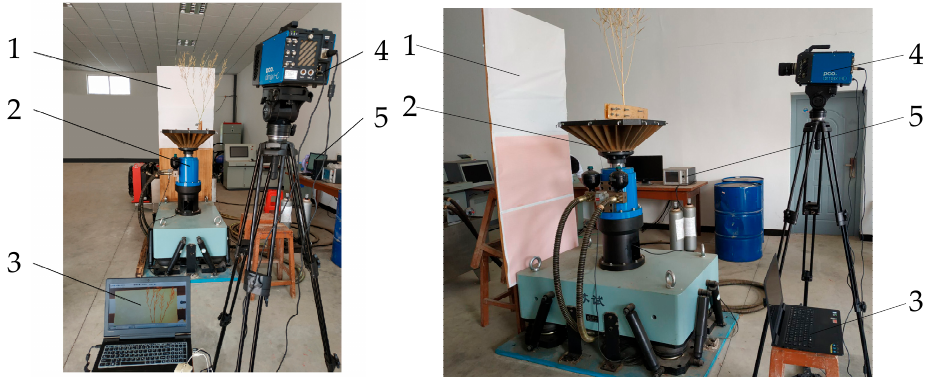
Figure 4. Experimental setup of rape plant vibration measurements: 1—background paper; 2—hy- draulic shaker; 3—computer; 4—high-speed camera; 5—hydraulic console.